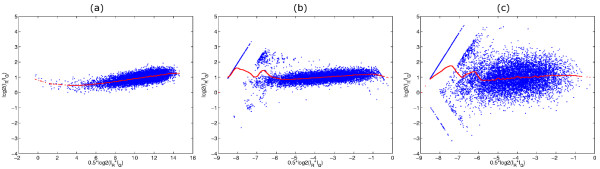
Scatter plots of the simulated data. MA-plot is shown for (a) noise free simulated data, (b) noise free data extracted from slide, and (c) realistic simulated data. Lowess fit is shown over each scatter plot to illustrate the trends in the data. All data points extracted from slide are scaled to [0,1] interval, thus the scale of the x-axis is different to the simulated noise free data.